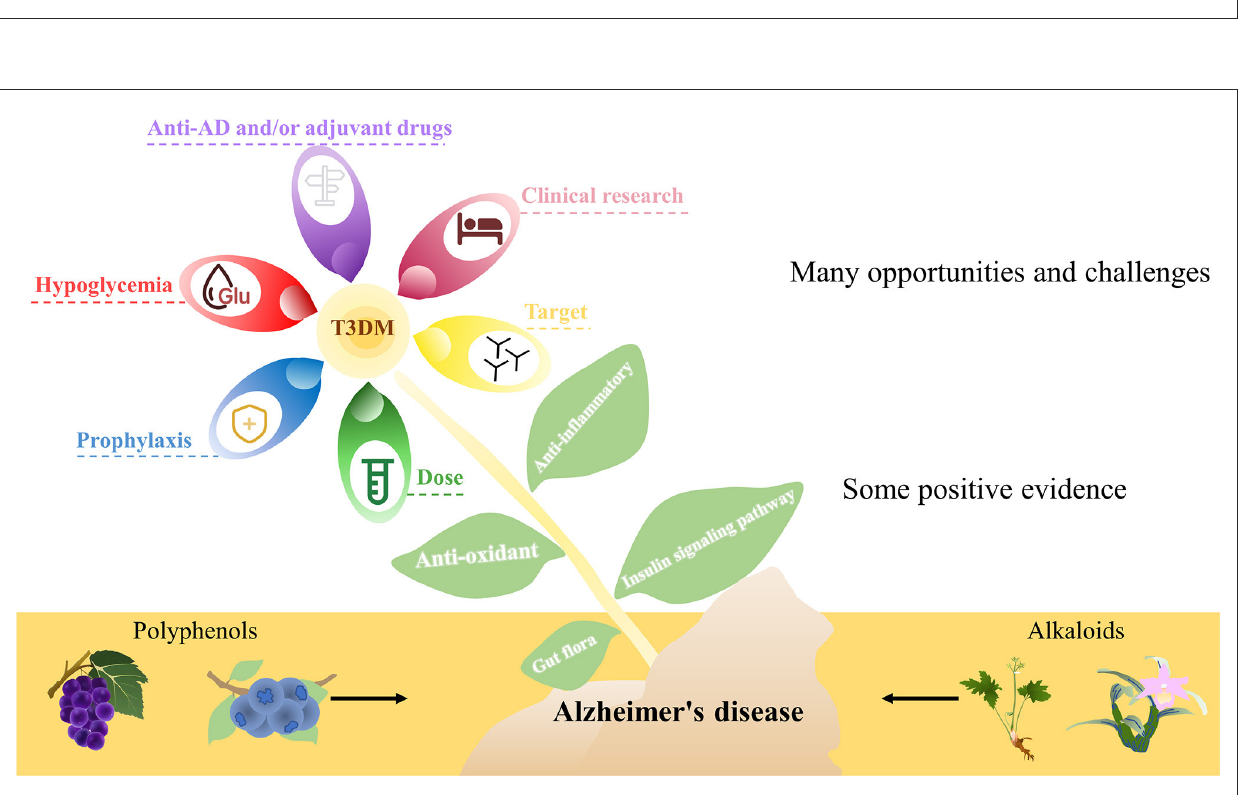
FIGURE2 A simplified schematic diagram representing natural bioactive compounds in AD. Although there are some positive pieces of evidence, there are still many opportunities and challenges, and there are still many issues worthy of discussion.